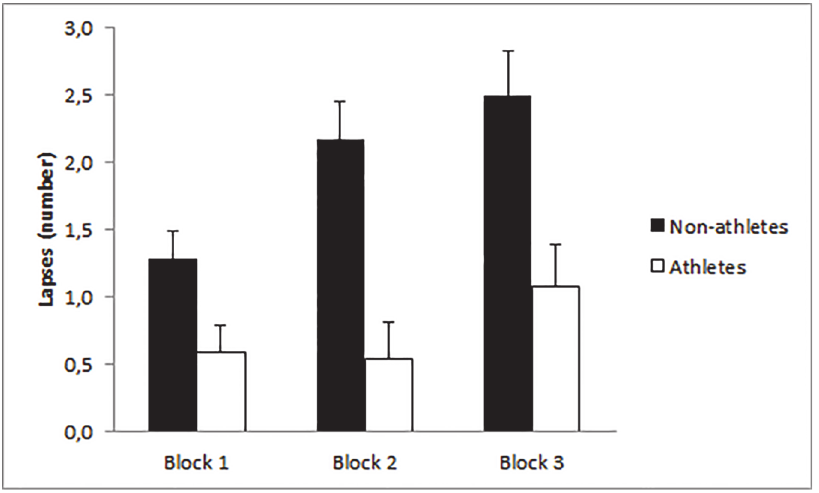
Fig 2. Lapses as a function of time on task and group. Number of lapses for the non-athletes and athletes group in each of the 3 blocks of the PVT. Bars represent standard errors of the mean. * p < .05